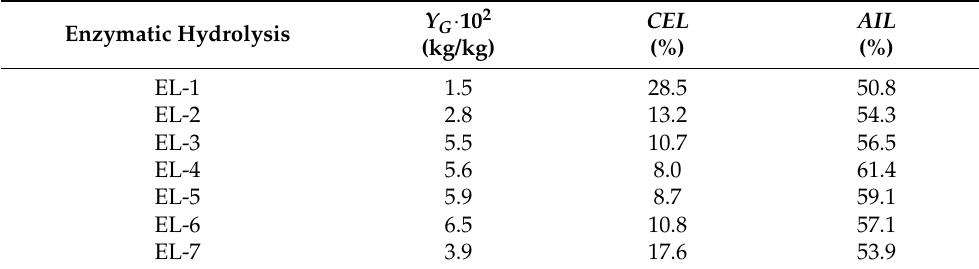
Table 6. D -glucose yields ( Y G ) and composition of the resulting solids from the enzymatic hydrolyses performed with different enzyme